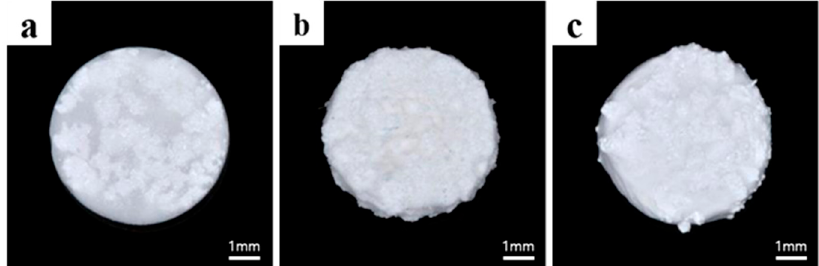
Figure 1. The specimens used in this study: ( a ) bisphasic calcium phosphate/carboxymethyl cellulose (BCP/CMC); ( b ) bisphasic calcium phosphate/cross-linked carboxymethyl cellulose (BCP/c-CMC); and ( c ) bisphasic calcium phosphate/ hyaluronic acid (BCP/HyA).